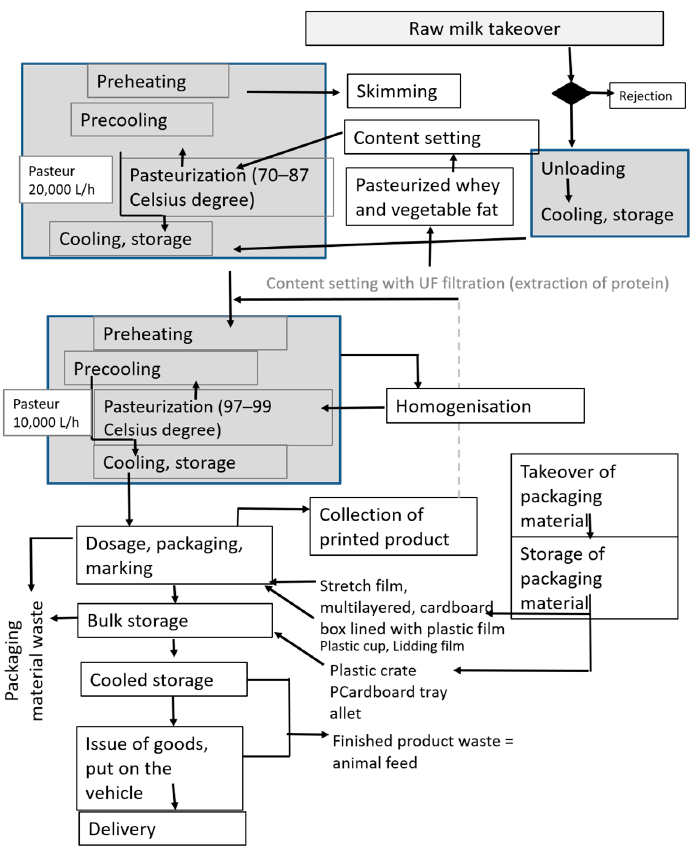
Figure A1. The process of dairy production in the case of the investigated enterprise. Source: Own editing based on the surveyed company data.